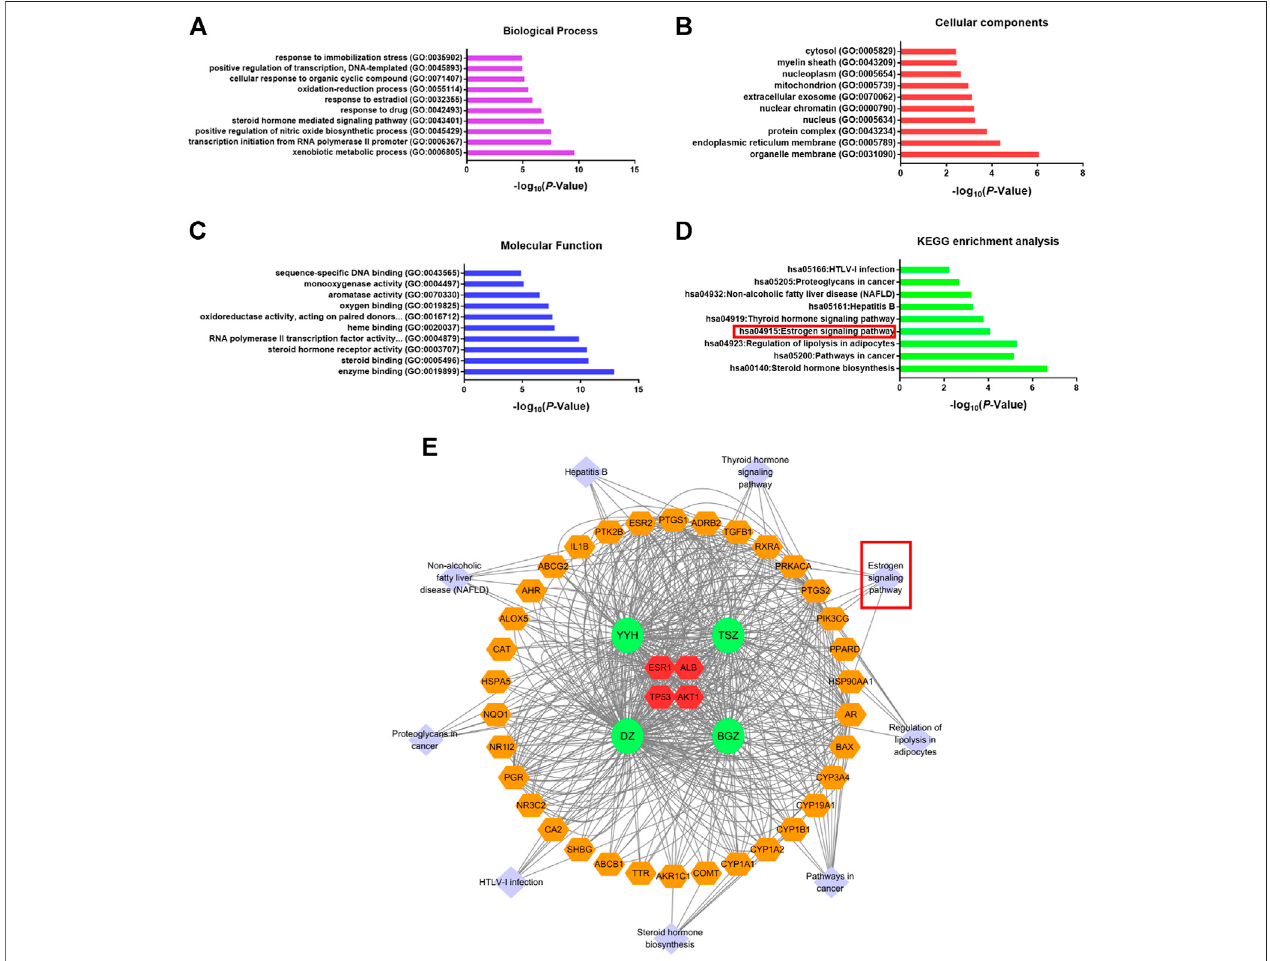
FIGURE 2 | Gene ontology and KEGG enrichment analysis. Gene ontology analysis of 38 cross-talking genes was displayed in 3 modules, including (A) biological process, (B) cellular components, and (C) molecular function. (D) KEGG signaling pathway enrichment analysis. (E) Pathway-herb-cross-talking genes network. The orangehexagonrepresentsthesameasin Figure3 .Thelightpurplediamondrepresentsthepathwaysenrichedby38cross-talkingtargets.Thegreencirclerepresents the herb.